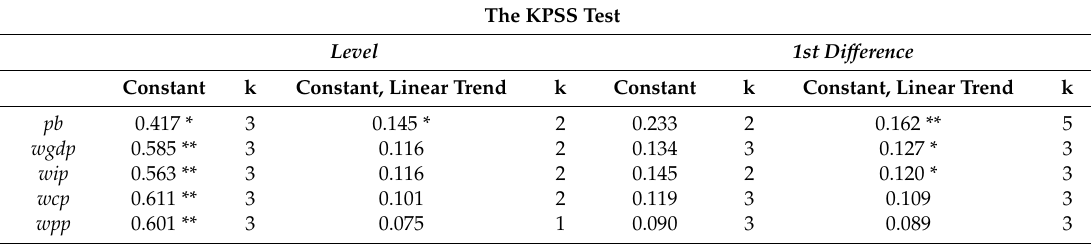
Table A10. W. The Unit Root test results.